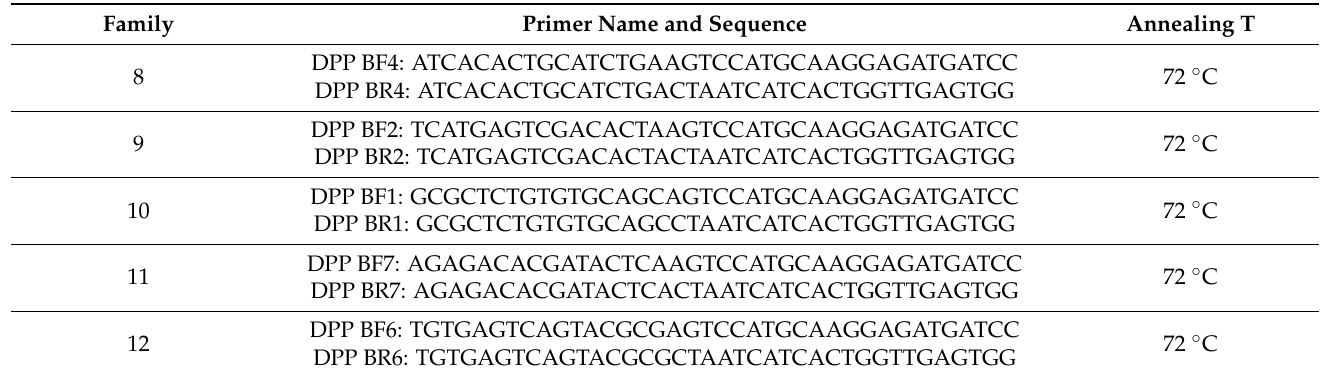
Table 5. PCR primer name, sequence, and reaction conditions for the PCR amplification to generate the SMRT sequencing template. The amplicon size ~2534 bp was expected based on the length of the DSPP cDNA reference sequence